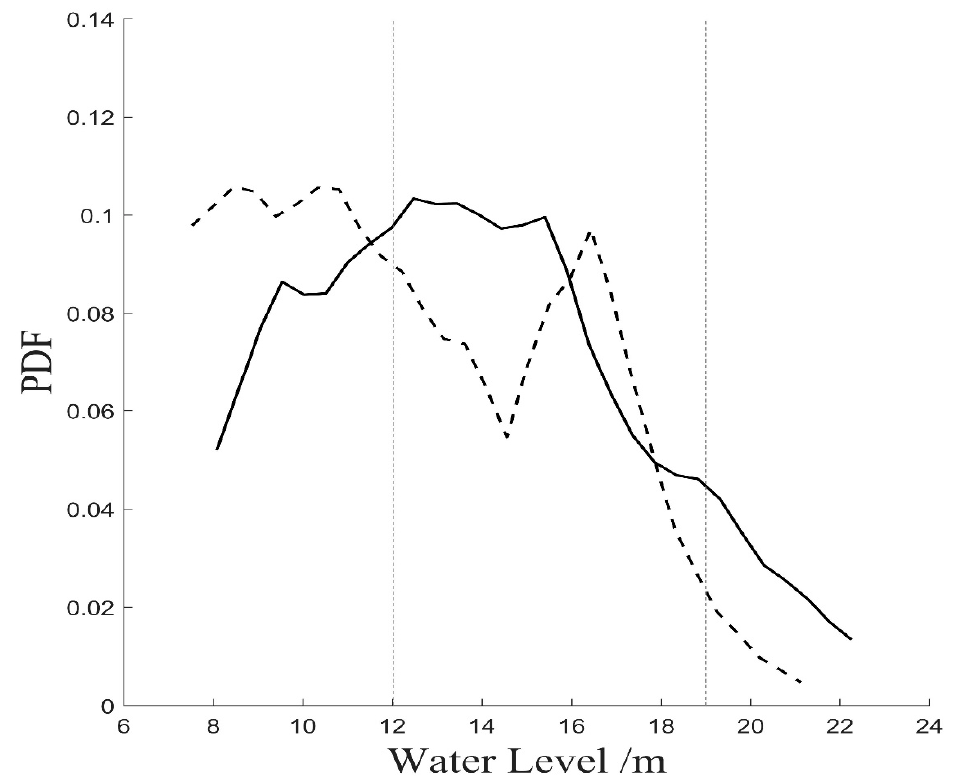
Figure 5. A comparison of the frequency distribution for water level between the two periods (1991–2002, 2004–2016). The solid line represents the frequency distribution of the water level in the early period, and the dashed line represent the frequency distribution in the latter period. The two vertical lines on the left and right represent the minimum ecological water level [62] and the warning water level, respectively.